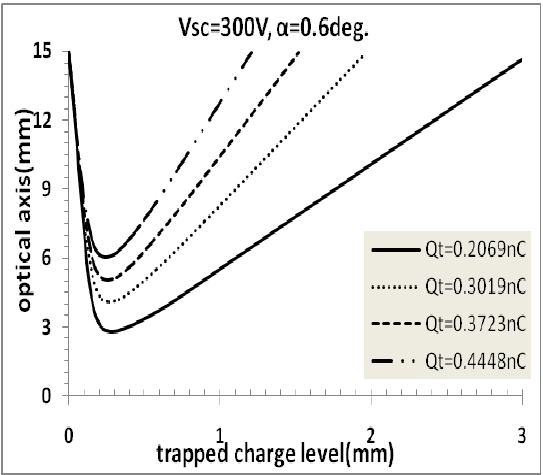
Fig.5: Different probing electron paths of a same incident angle reflects to different areas.